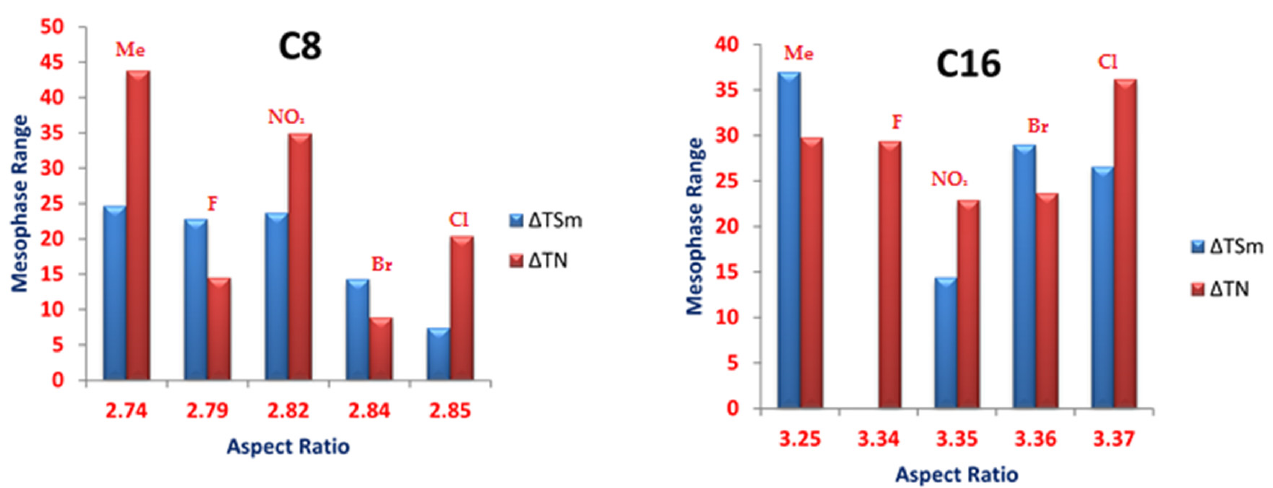
Figure 8. Dependence of the mesomorphic range with the calculated aspect ratios.